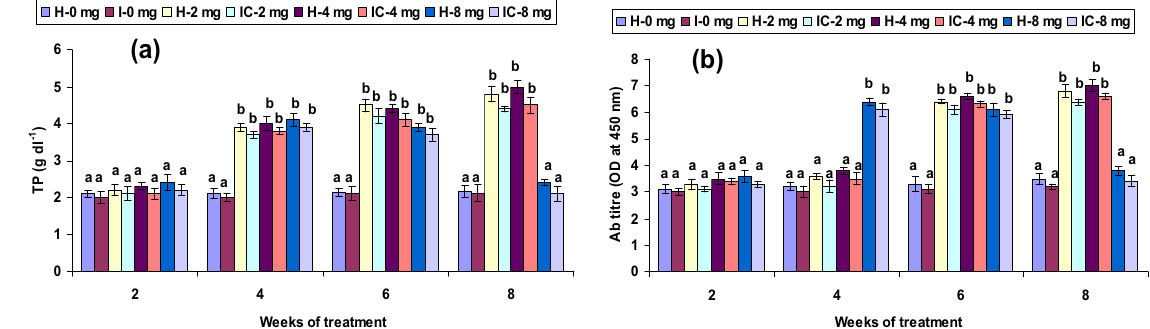
Figure 6. ( a ) Total protein (TP) level and ( b ) antibody (Ab) titre of catla (n = 6) head kidney leucocytes against A. hydrophila . H healthy, I infected. Data are expressed as mean ± SD and the statistically significant difference ( P < 0.05) between mean values as indicated in different letters in each column.